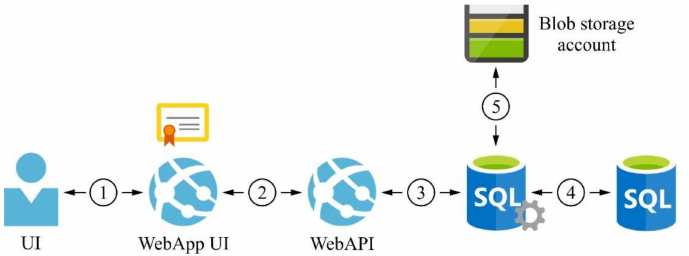
Figure 7. Cloud infrastructure: 1—https; 2—https, representational state transfer (REST)